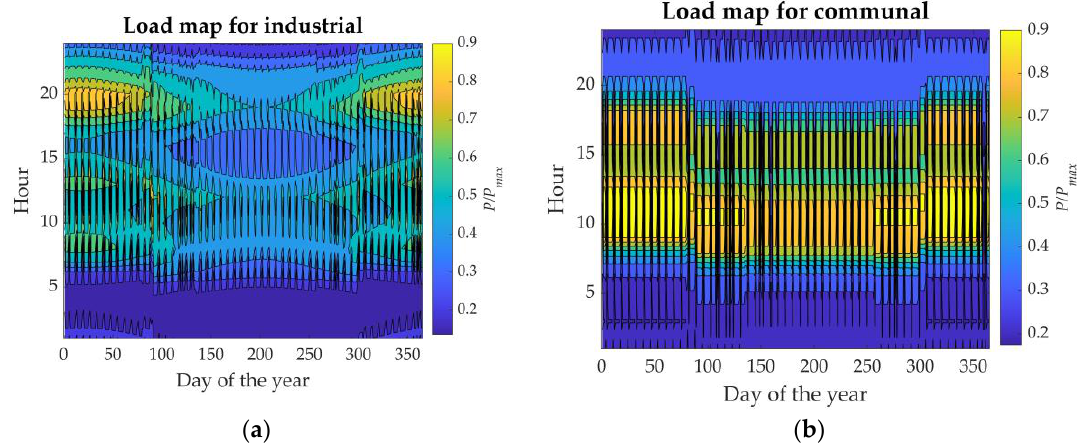
Figure 2. Annual load map (2014) for: ( a ) industrial load; ( b ) communal load.